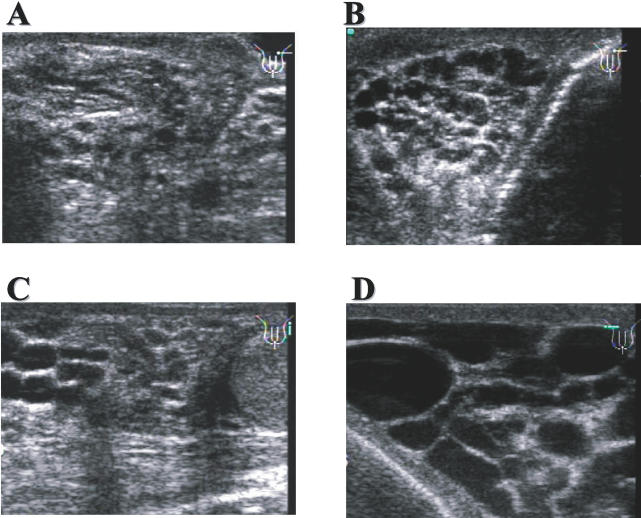
Grading of the Supratesticular Lymphatic Vessel Dilation of Filarial-Infected Patients Displayed by USGDilation of the supratesticular lymphatic vessels was determined by measuring the largest diameter detectable in the two-dimensional b-mode of a portable ultrasound machine. A grading system was developed to determine the degree of lymphatic dilation as follows: (A) category 1: patients with minimal lymphatic dilation of up to 0.2 cm; (B) category 2: patients with mild dilation from 0.21–0.50 cm; (C) category 3: patients with moderate dilation from 0.51–1.0 cm; and (D) category 4: patients with severe dilation of above 1.0 cm.